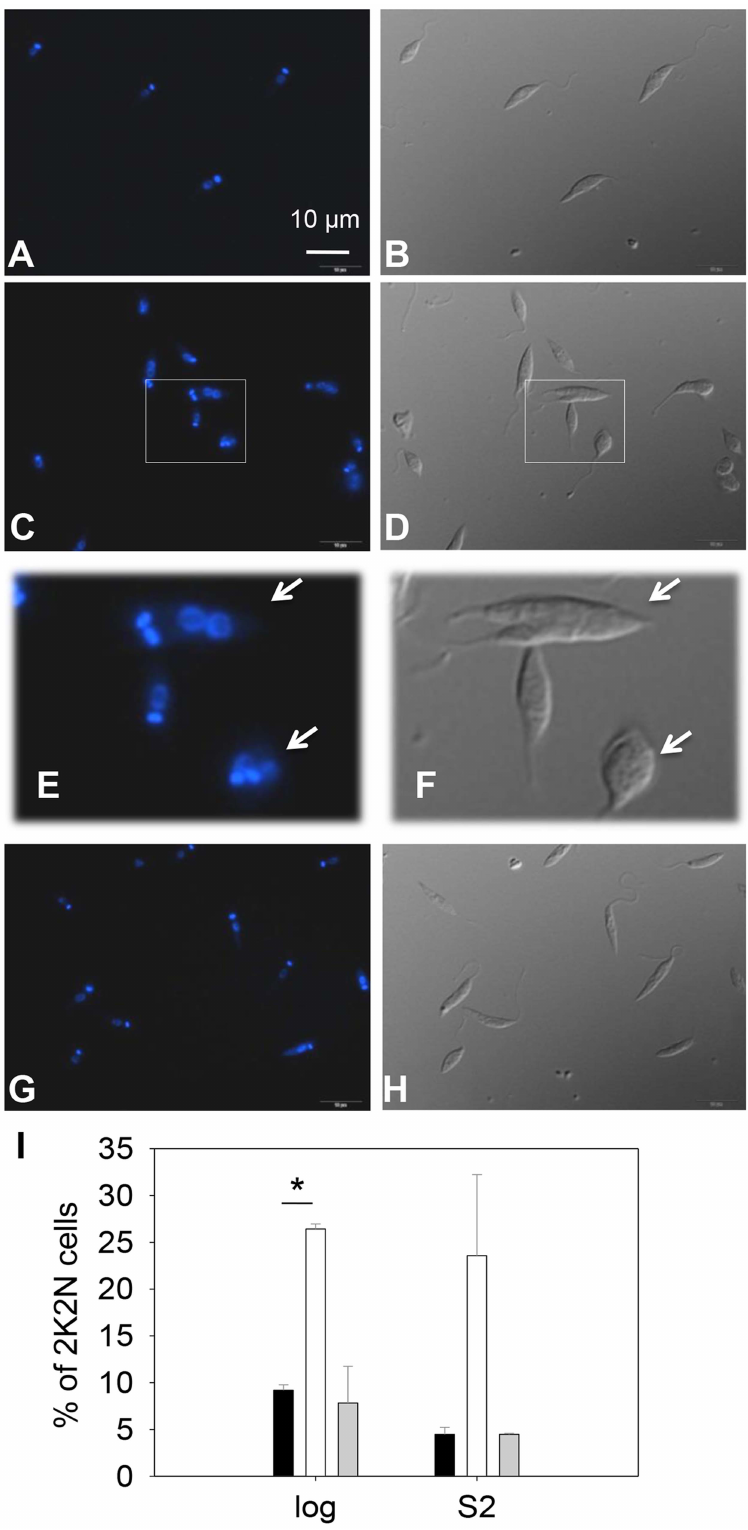
Figure 3. C14dm 2 promastigotes exhibit cytokinesis defects. Log phase promastigotes of WT ( A – B ), c14dm 2 ( C – F ), and c14dm 2 / + C14DM ( G – H ) were stained with Hoechst 33242 and analyzed by fluorescence microscopy. E and F are enlargements of the boxed regions in C and D , respectively. DNA staining results were shown in A , C , E and G . DIC images were shown in B , D , F , and H . ( I ) Percentages of 2 kinetoplastids-2 nuclei (2K2N) cells were determined in log and day 2 stationary phase (S2) promastigote cultures. Black bars: WT, white bars: c14dm 2 , grey bars: c14dm 2 / + C14DM (*: p , 0.05). Experiments were repeated three times ( , 200 cells were counted for each cell type in every experiment) and error bars represent standard deviations. Examples of 2K2N cells are marked by arrows in E and F . doi:10.1371/journal.ppat.1004427.g003 PLOS Pathogens | www.plospathogens.org